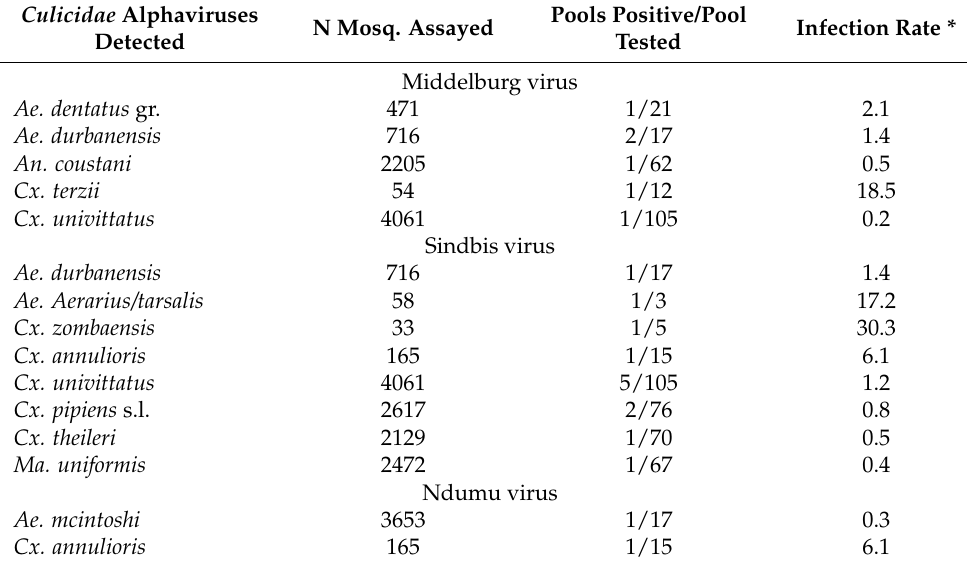
Table 1. Mosquito species that tested positive for